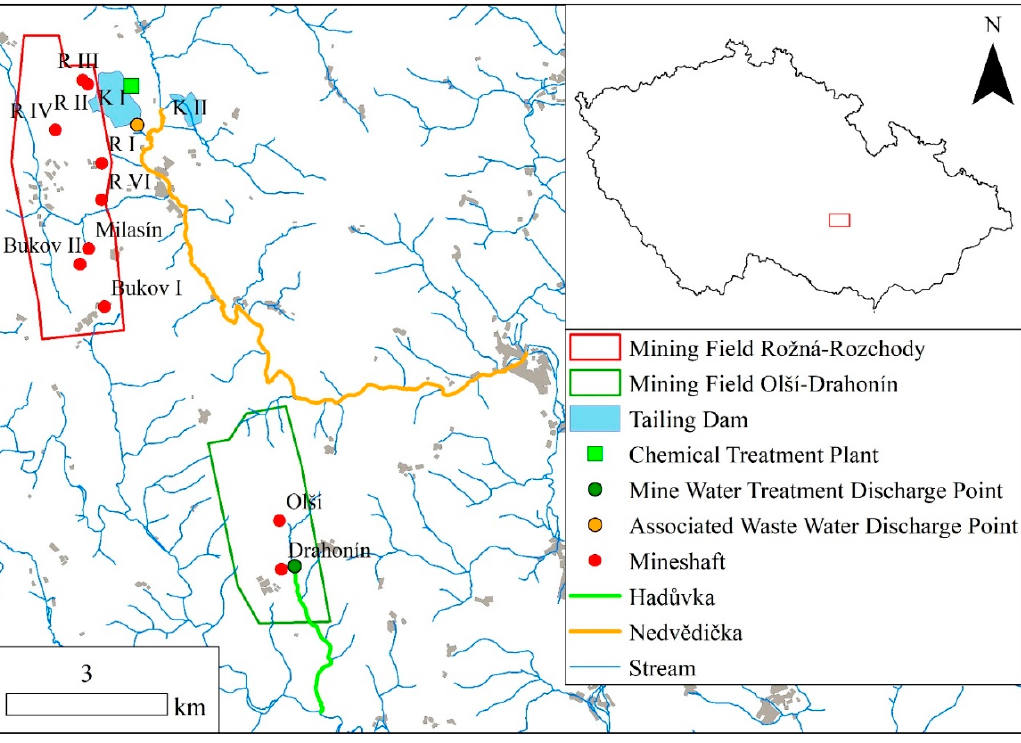
Figure 1. The area of interest.